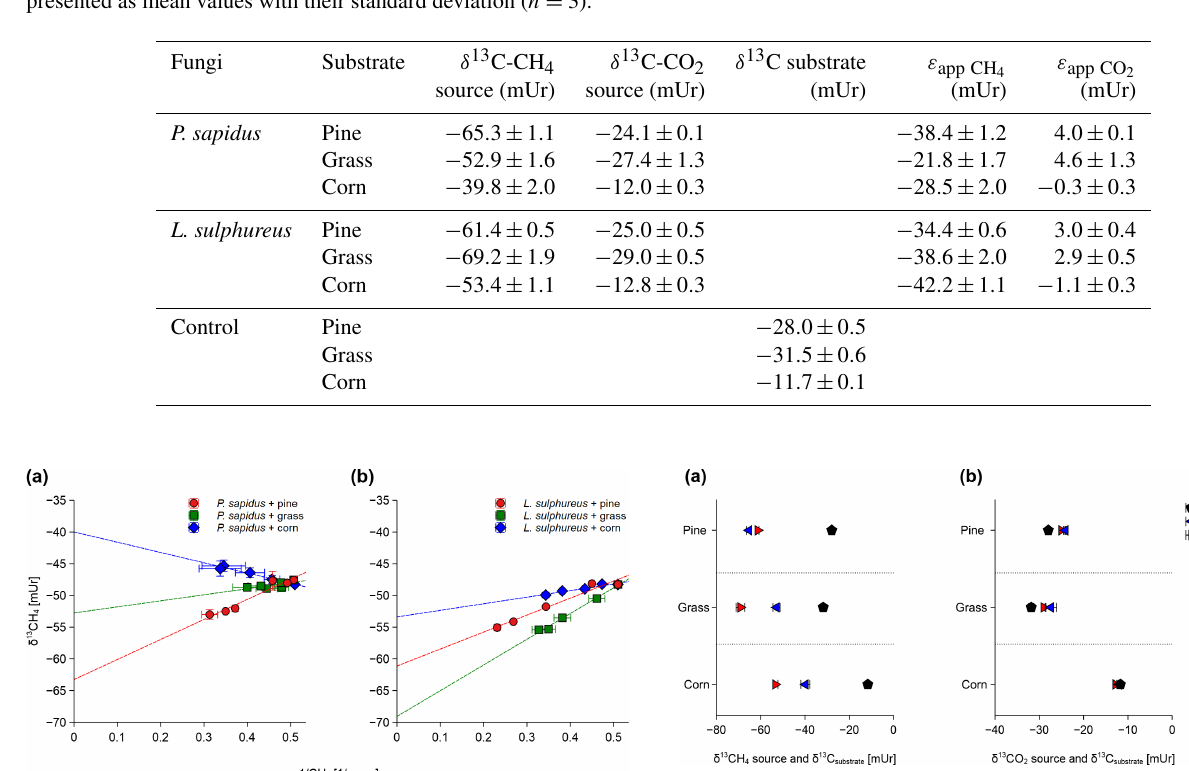
. Values are and ε app CO 2 4